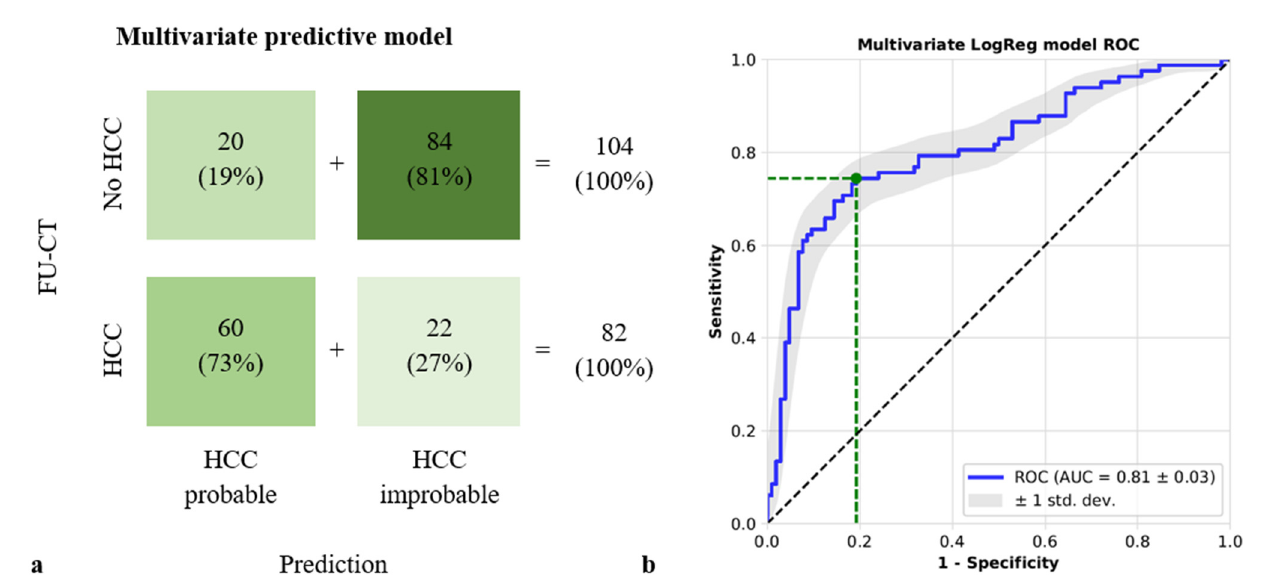
Figure 5. ( a ) Confusion matrix for the prediction of HCC in segmentations of the cirrhotic liver in the multivariate model integrating the four features (correlation, IMC1, IMC2, and kurtosis). IMC1 and IMC2 (informational measure of correlation 1 and 2) and correlation represent texture features, whereas kurtosis is a representative of the first-order features. ( b ) ROC for the multivariate model including the four imaging features outlined above for dichotomizing segmentations into HCC probable and HCC improbable regions. HCC—hepatocellular